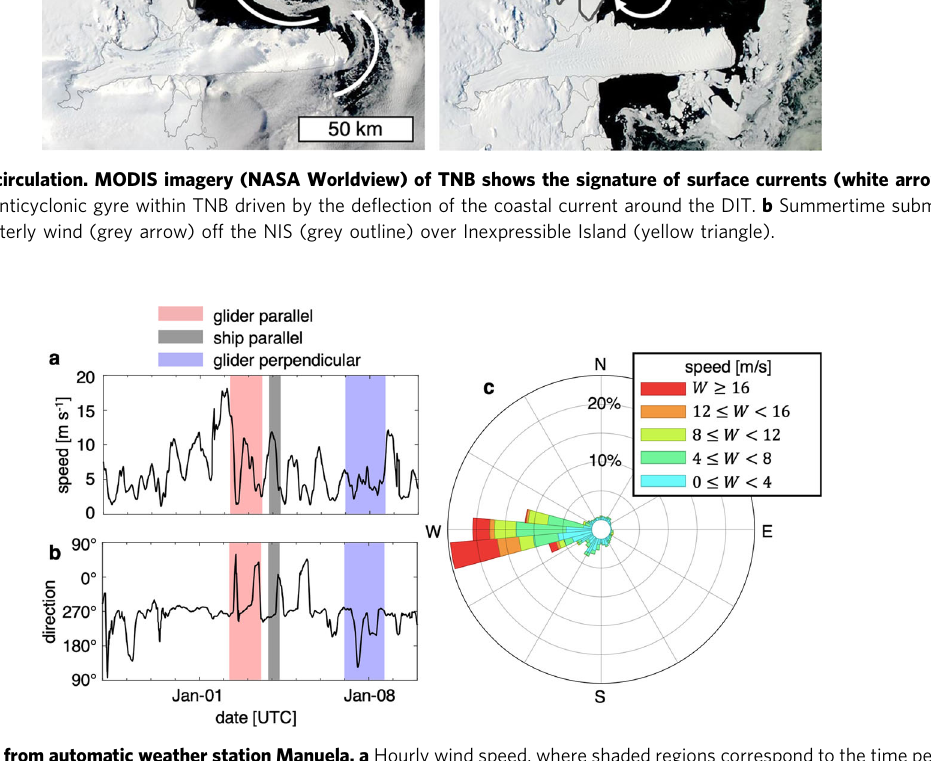
Fig. 3 Atmospheric data from automatic weather station Manuela. a Hourly wind speed, where shaded regions correspond to the time periods over which the data was collected. b Hourly wind direction (from). c Compass plot of wind speed and direction corresponding to the data in a , b